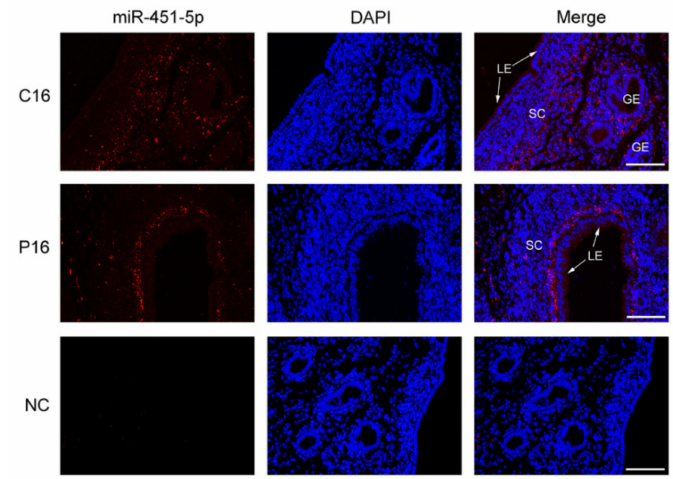
Figure 7. Chi-miR-451-5p expressed in stromal cells of the endometrium. Fluorescence in situ hybridization (FISH) assays for miR-451-5p in the endometrium on C16 and P16 tissue samples ( n =3). Scale bar = 100 µ m. Legend: C16, on day 16 of the estrous cycle; P16, on day 16 of pregnancy; LE, endometrial luminal epithelium; GE, glandular epithelium; SC, stroma cell.